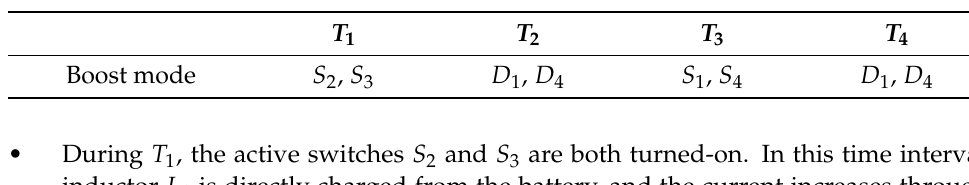
Table 1. Conduction of switches in different time intervals in B2DC